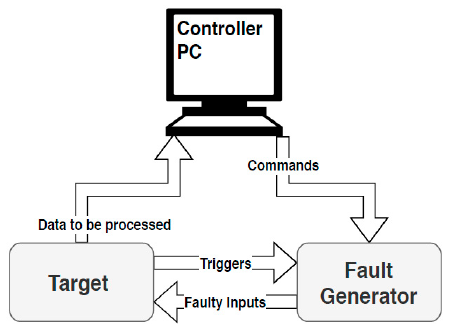
Figure 1. General fault injection attack set-up .